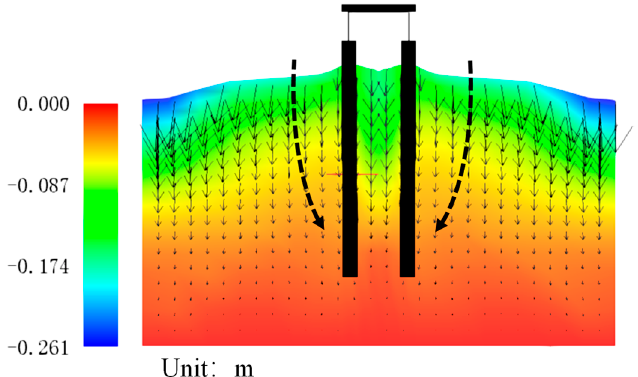
Figure 23. Displacement vector at the end of dynamic loading (deformation being amplified 10 times).